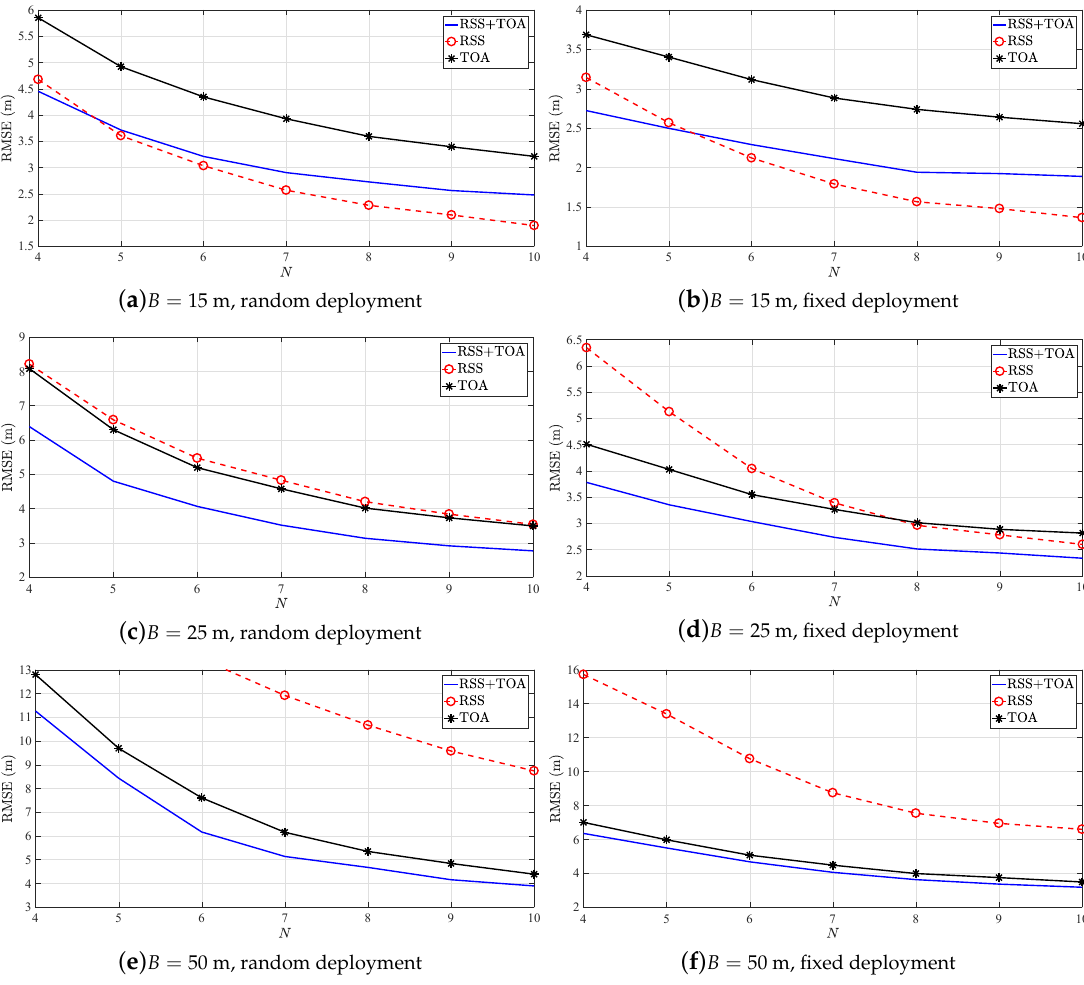
Figure 2. Root mean squared error (RMSE) versus N comparison for